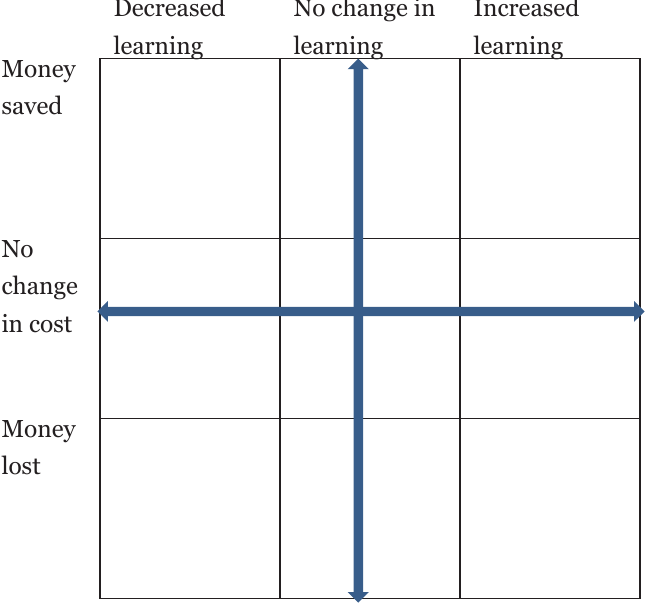
Figure 1. Possible outcomes in cost and education when using